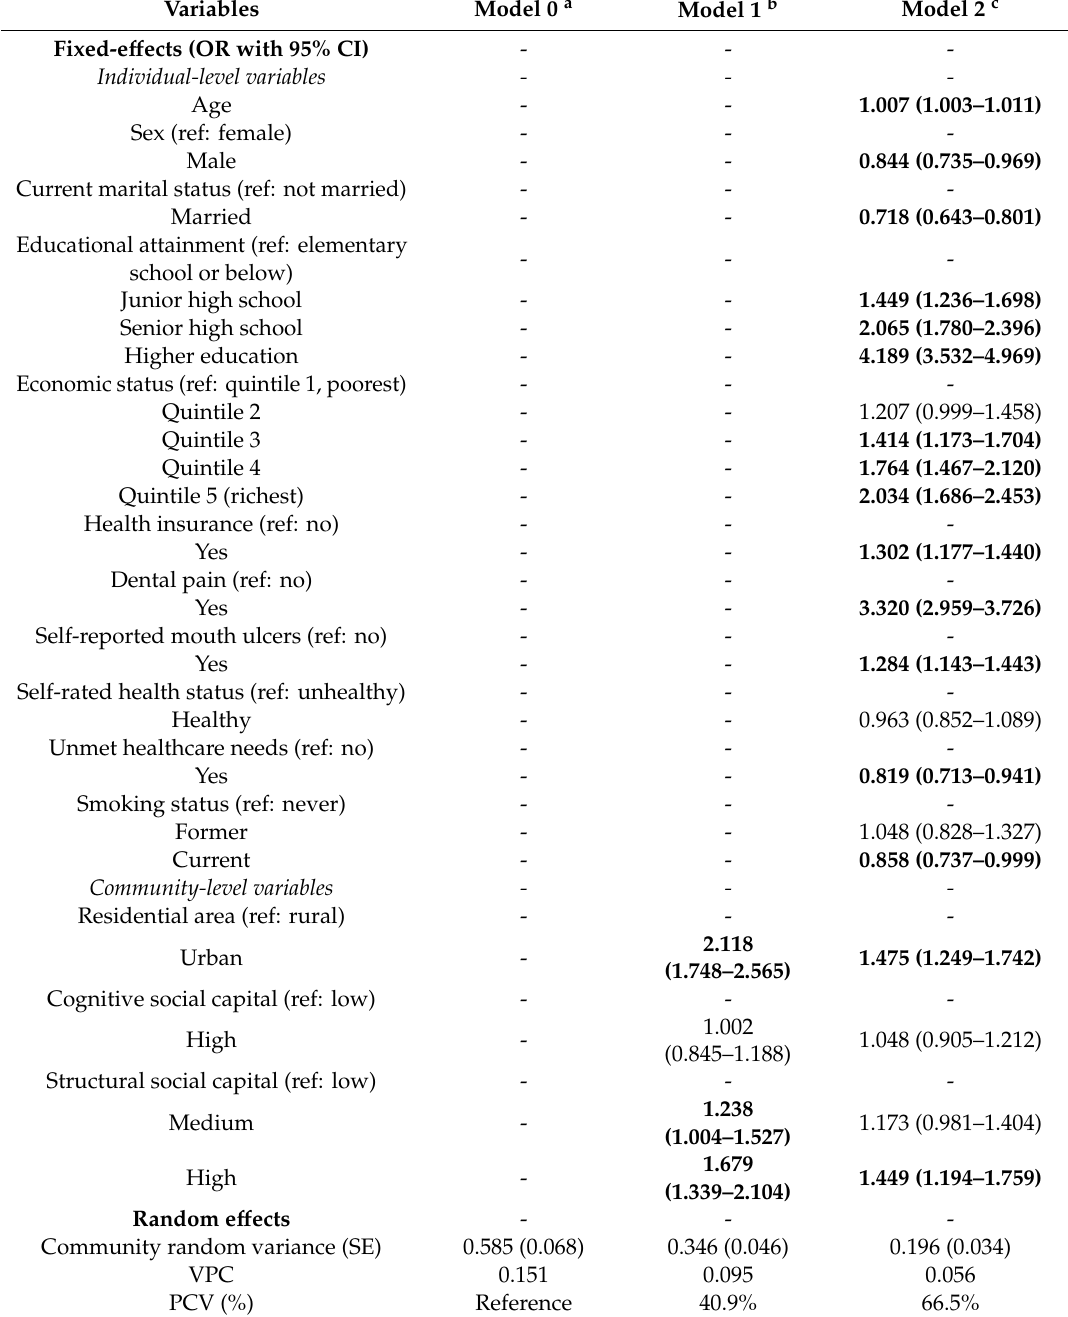
Table 2. Individual and community characteristics associated with dental service